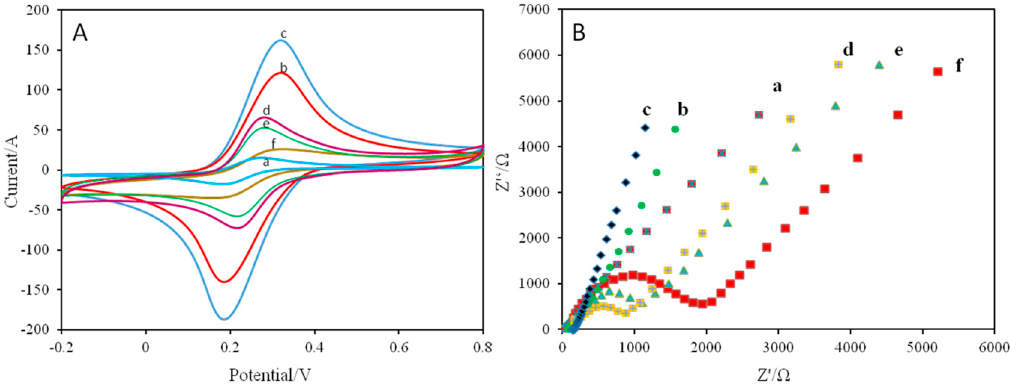
Figure 2. ( A ) Cyclic voltammagrams and ( B ) electrochemical impedance spectroscopy of ( a ) bare GCE, ( b ) AuNPs/GCE, ( c ) AuNPs/cSWNTs/CS ( d ) T-2-OVA-cSWNTs/CS/AuNPs, ( e ) anti-T-2/FB1-BSA- SWNTs/CS/GCE, ( f ) ALP-anti-antibody/anti-T-2/T-2-SWNTs/CS/AuNPs/GCE in 5 mM [Fe(CN)6] 3 − /4 − containing 1 M